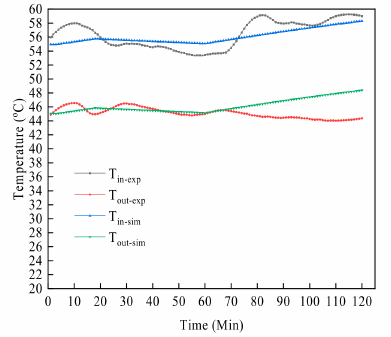
Figure 4. Diagram of comparison and verification of inlet and outlet temperatures of the DR.